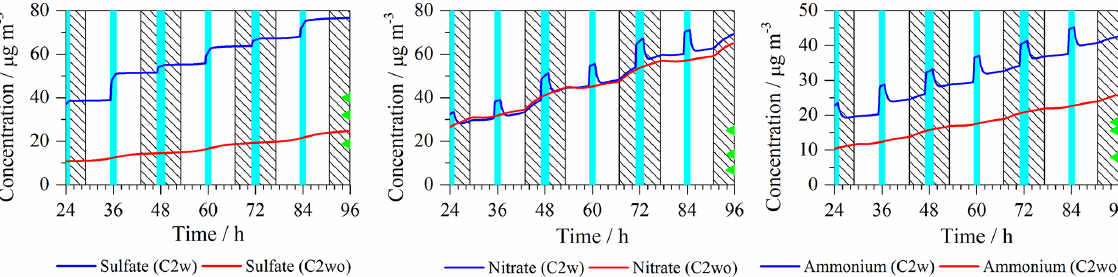
Figure 3. Time series of the modeled aerosol mass concentrations (µgm − 3 ) of key secondary inorganic aerosol constituents (sulfate, nitrate and ammonium) in the C2w and C2wo cases. Light blue column: cloud; shadow: night; green triangle: the maximum (above), average (middle), and minimum (below) value of measured concentration at Mt. Tai.